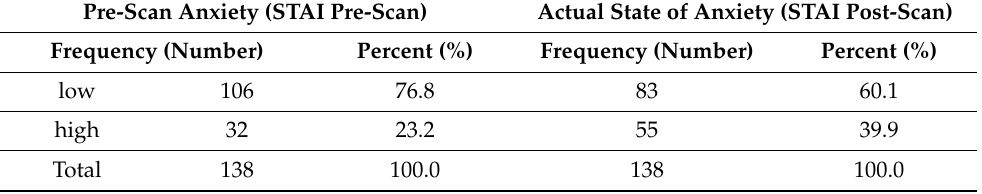
Table 1. Anxiety